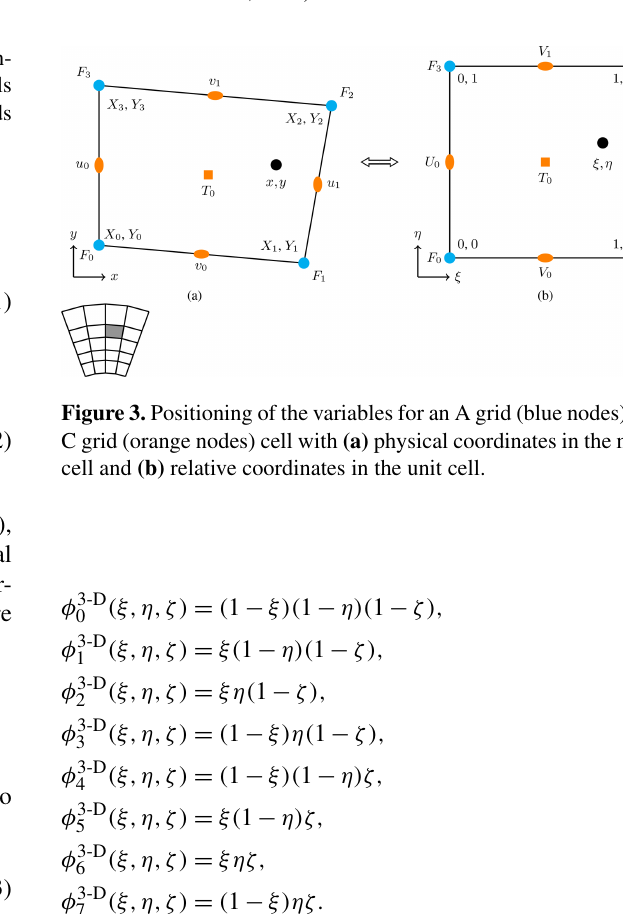
Figure 2. Arakawa’s staggered grids (Arakawa and Lamb, 1977): (a) A grid and (b) C grid. In the C grid, i and j represent the variable column and row indexing in arrays where the variables are stored. The indexing of the C grid follows the NEMO notations (Madec and the NEMO team, 2016).